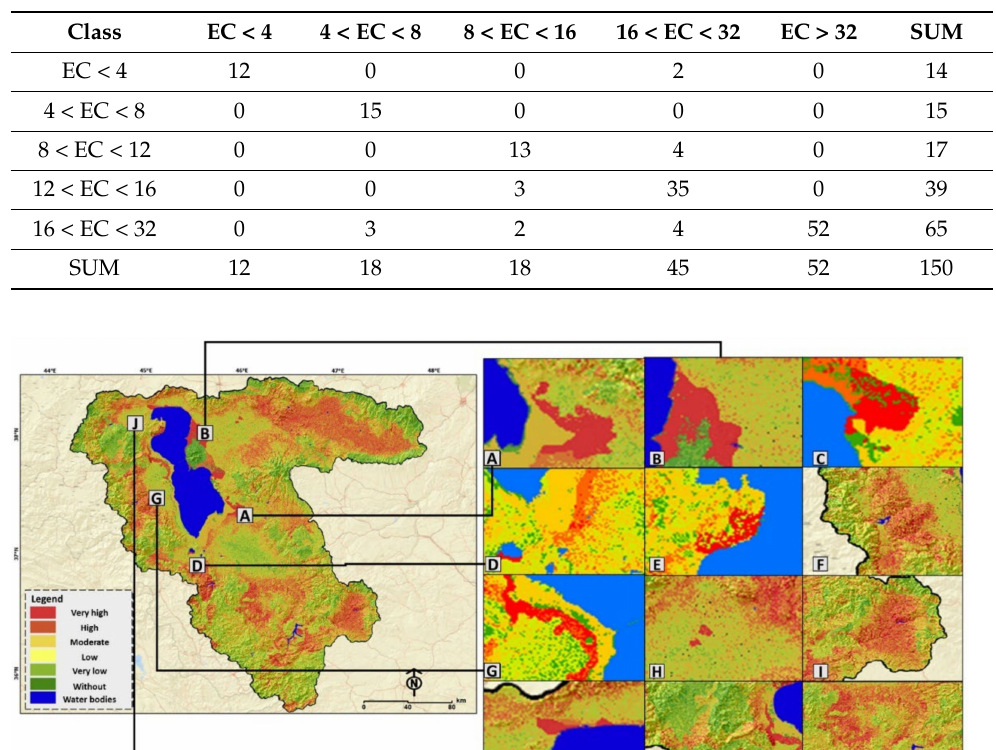
Table 8. Field observation data matrix (soil electrical conductivity) based on the ground control sample points and computed EC.